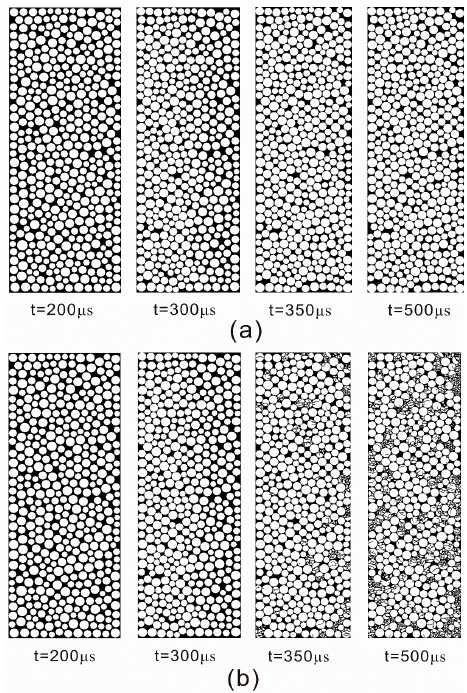
Figure 6. Snapshots of the configuration change of the filled particles at different times. ( a ) The result of the non-crushing model; ( b ) The result of the crushing model.